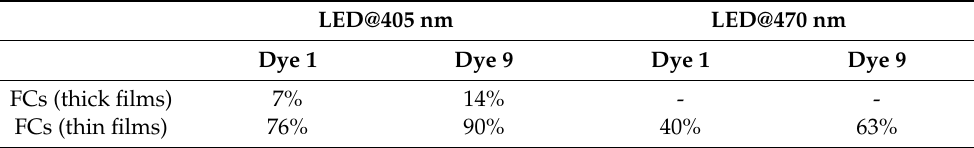
Table 3. Final conversions obtained during the FRP of PEGDA in thick and thin films using the three-component benzylidene ketones/amine/Iod (0.1%/2%/2%, w / w / w ) system, irradiation at 405 or 470 nm with a LED for 200 s. Data extracted from Ref. [151].